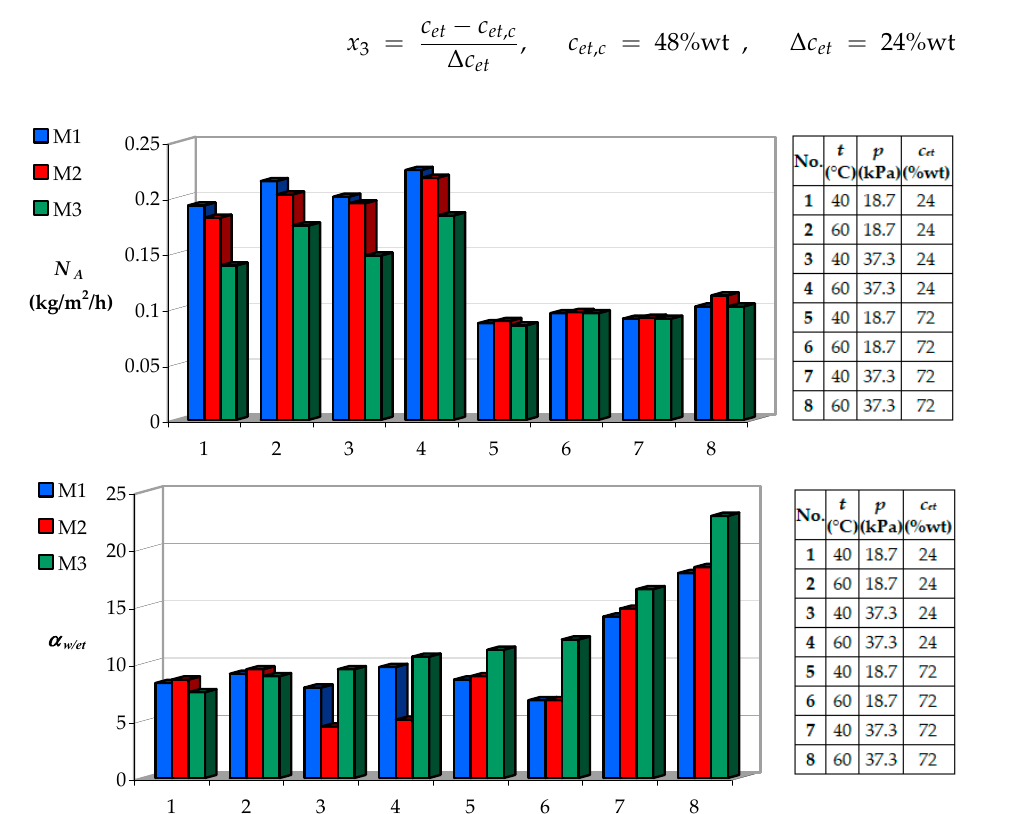
Figure 9. Permeate flow rate and membrane selectivity for pervaporation through PVA-BC membranes (M1: PVA-BC 12/6, M2: PVA-BC 12/12, M3: PVA-BC 12/18).